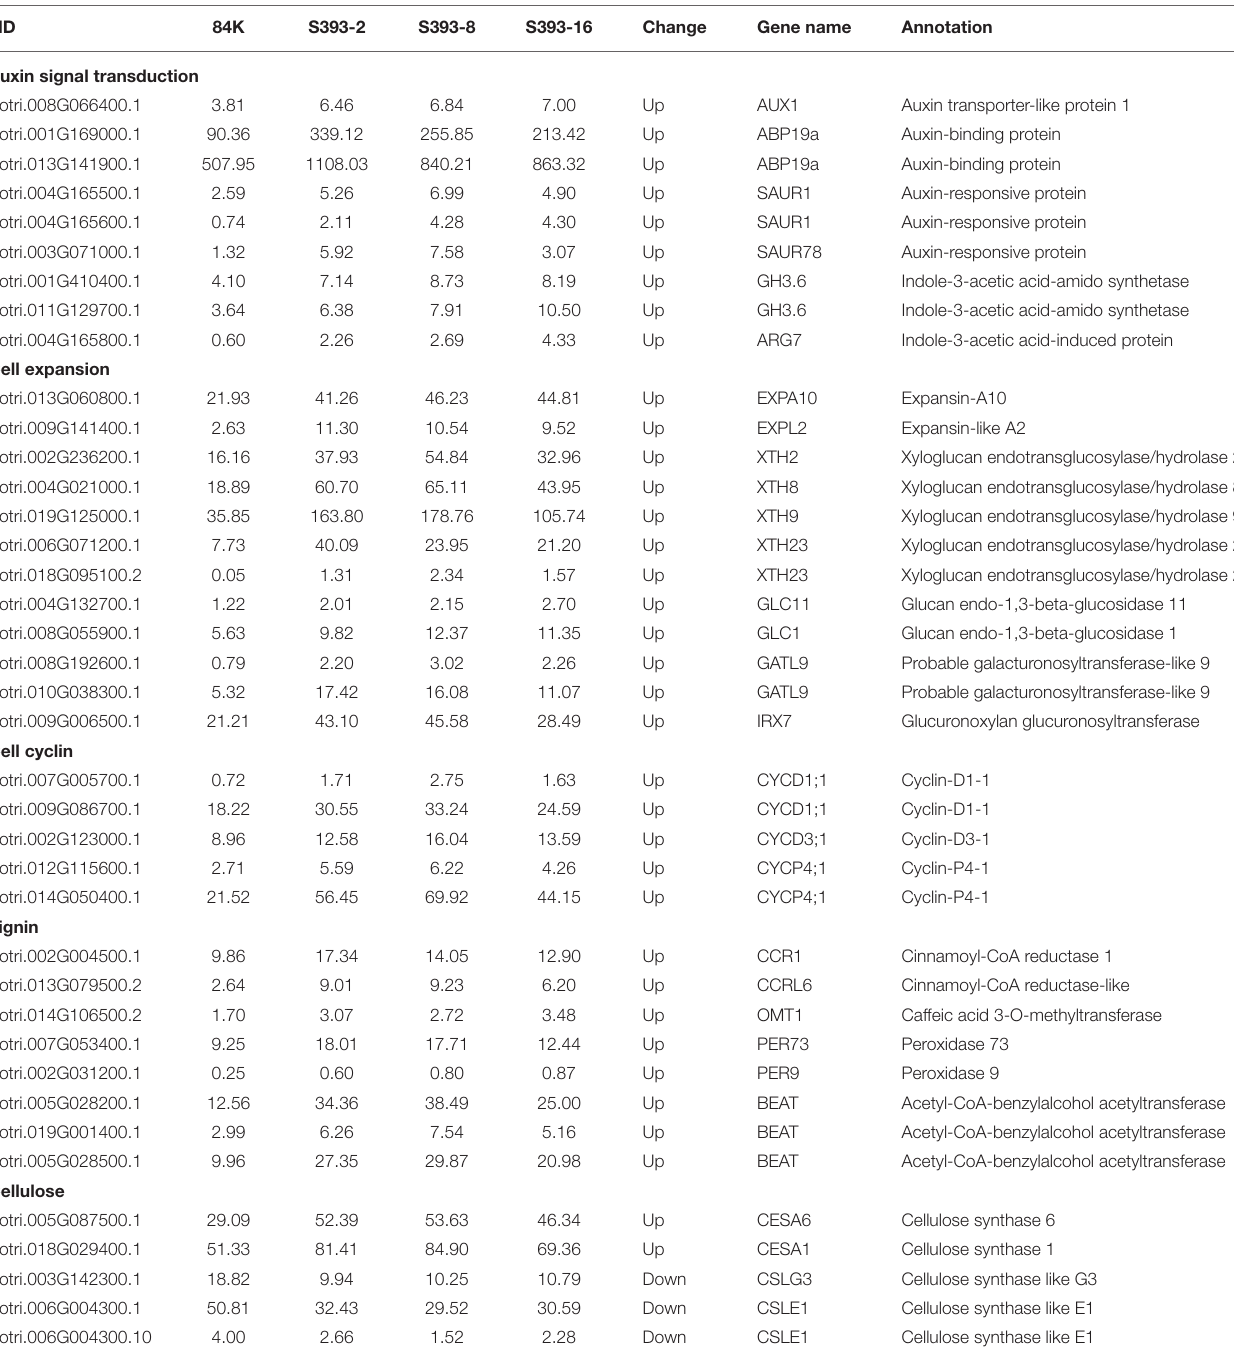
TABLE 1 | The differently expressed genes related to plant growth and wood formation. #ID